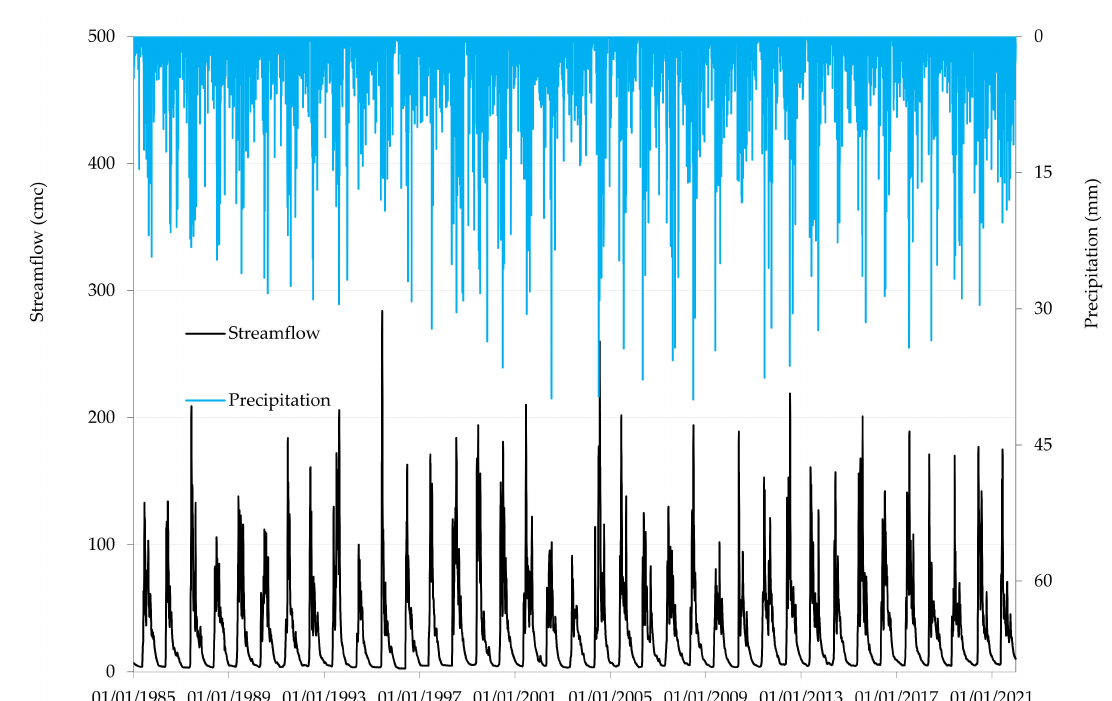
Figure 2. Hydrograph of the measured streamflow vs. measured precipitation.